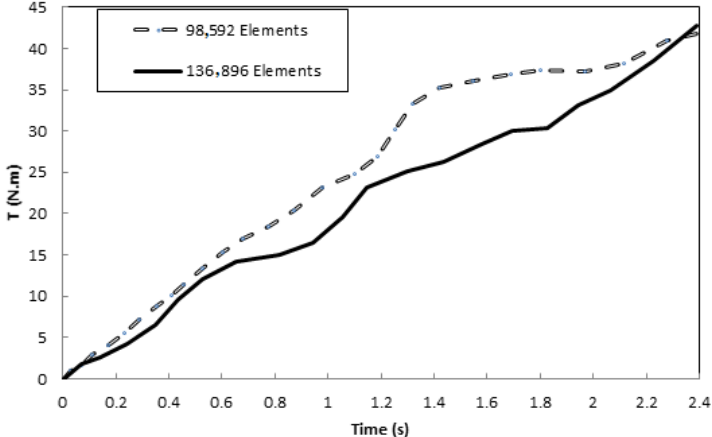
Figure 7. Measured torque at the end of one complete rotation ( T max ) with two different mesh sizes with a friction angle of 34° and a vertical effective stress of 110 kPa.